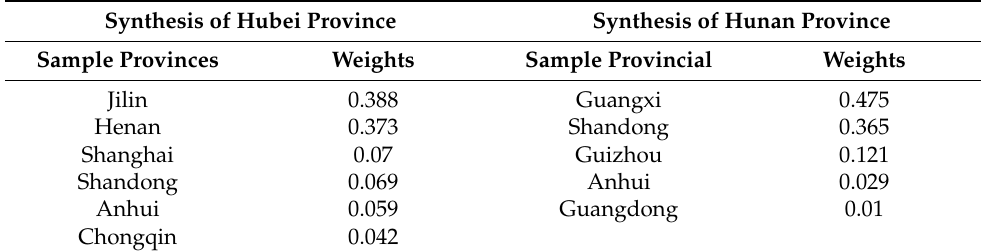
Table 1. Nonzero weights for samples of synthetic PM2.5 particulate